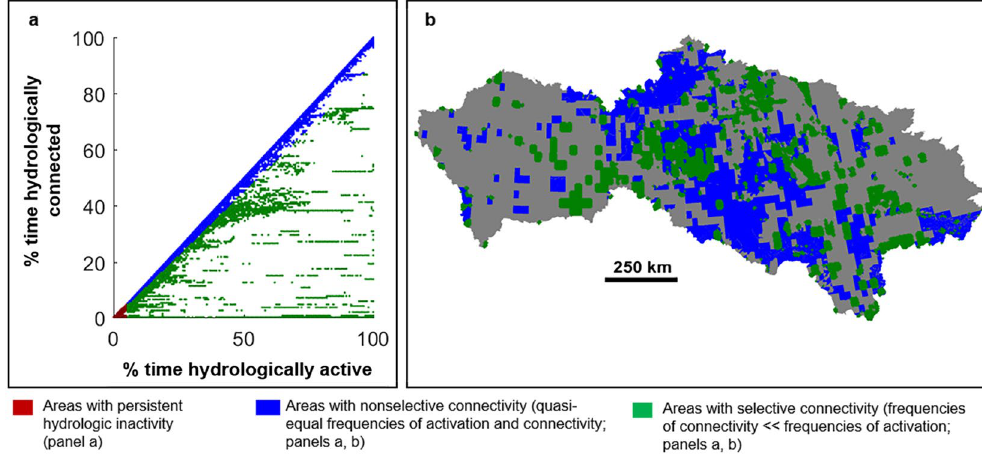
Figure 6. Typology of connectivity establishment in the Lake Winnipeg Watershed. ( a ) Classification of watershed areas as persistently inactive (% time with hydrologic activity < 5%), with nonselective connectivity (i.e., % time hydrologically active ≈ % time hydrologically connected), and with selective connectivity (% time hydrologically connected ≪ % time hydrologically active). ( b ) Identification of non-selectively and selectively connected areas within the Lake Winnipeg Watershed. For better clarity, persistently inactive watershed areas are not shown in red on the map. The plots were created using MATLAB (version R2016a,